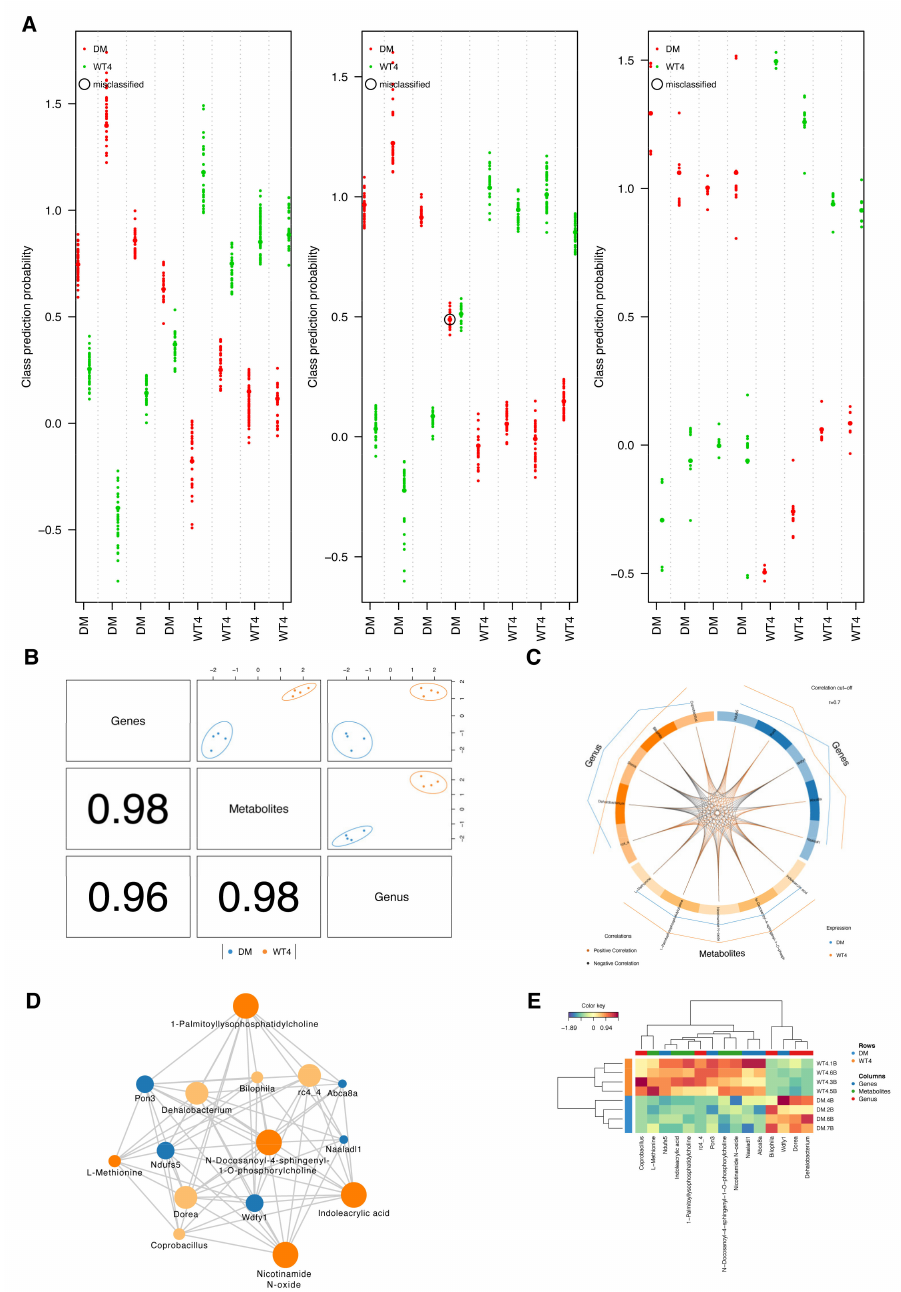
Figure 10. Performance of integrative modeling on multi-omics in db/db and WT mice. ( A ) Swim lane plots for classification analysis using multivariate methods with unbiased variable selection in R (MUVR). Each lane presents predictions for each sample, individually and overall. The colors of the dots represent the prediction of classes. The smaller dots indicate the class probabilities from individual repetitions, while the larger dots represent probabilities averaged over all repetitions. Circled dots represent the misclassified predictions. ( B ) The diagnostic plot indicates the correlation between components from each omics data and the power to separate two groups of mice. ( C , D ) The circos plot and relevance network represent correlations between selected signatures from each omics data. Orange and black edges of the circos plot indicate positive and negative correlations, respectively. The size of each node in the relevance network represents the betweenness centrality. ( E ) The heatmap represents the scaled expression of selected signatures from each omics